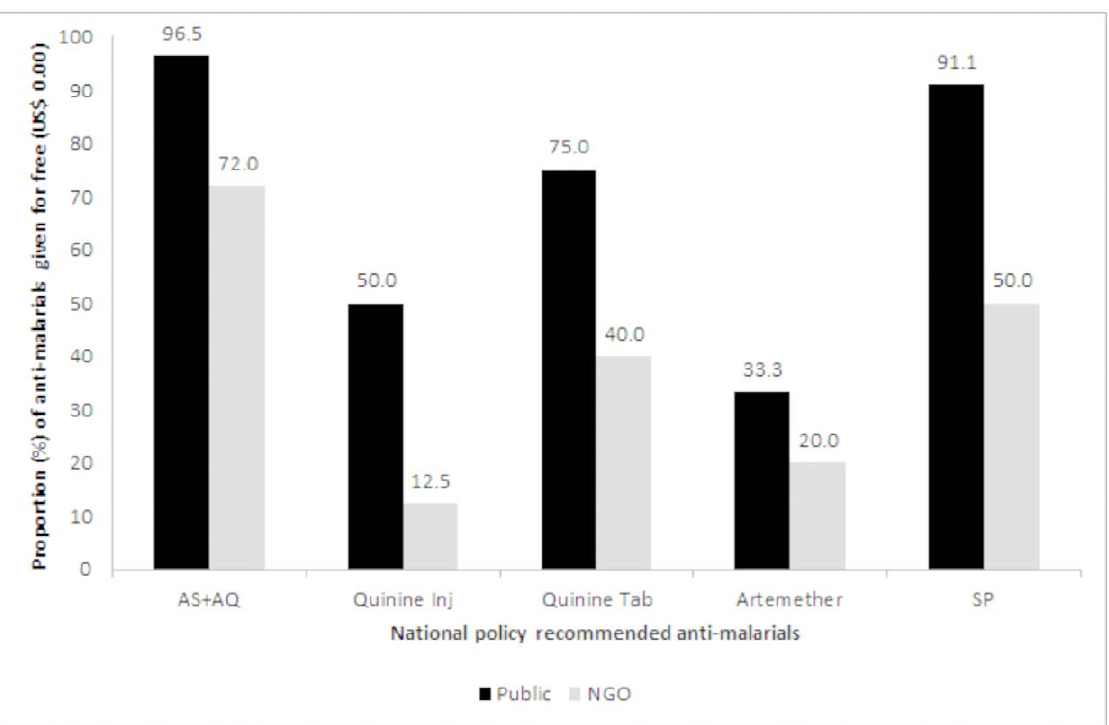
Figure 2. Proportion of national policy recommended anti-malarials offered for free ( $ USD 0.00) in the public and NGO sector medicine outlets surveyed in Sierra Leone. Artemether-lumefantrine was not found in the public sector and was not offered for free in the NGO sector.